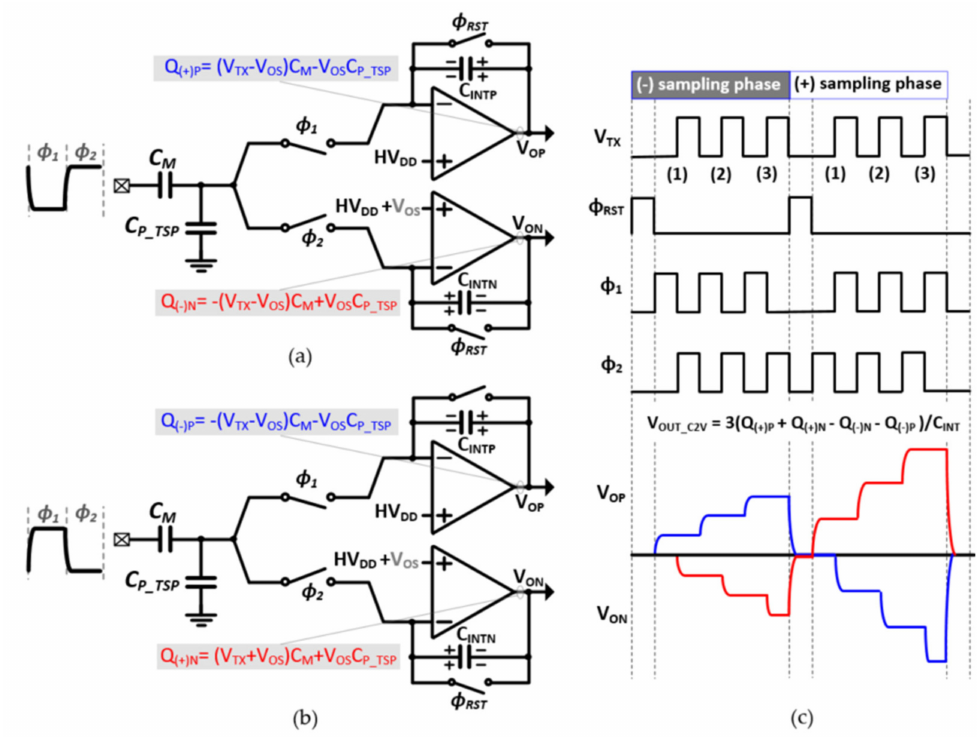
Figure 7. C2V configuration for ( a ) the negative offset sampling phase ( φ 1 = high, V TX = low), ( b ) the positive offset sampling phase ( φ 1 = high, V TX = high), and ( c ) its timing